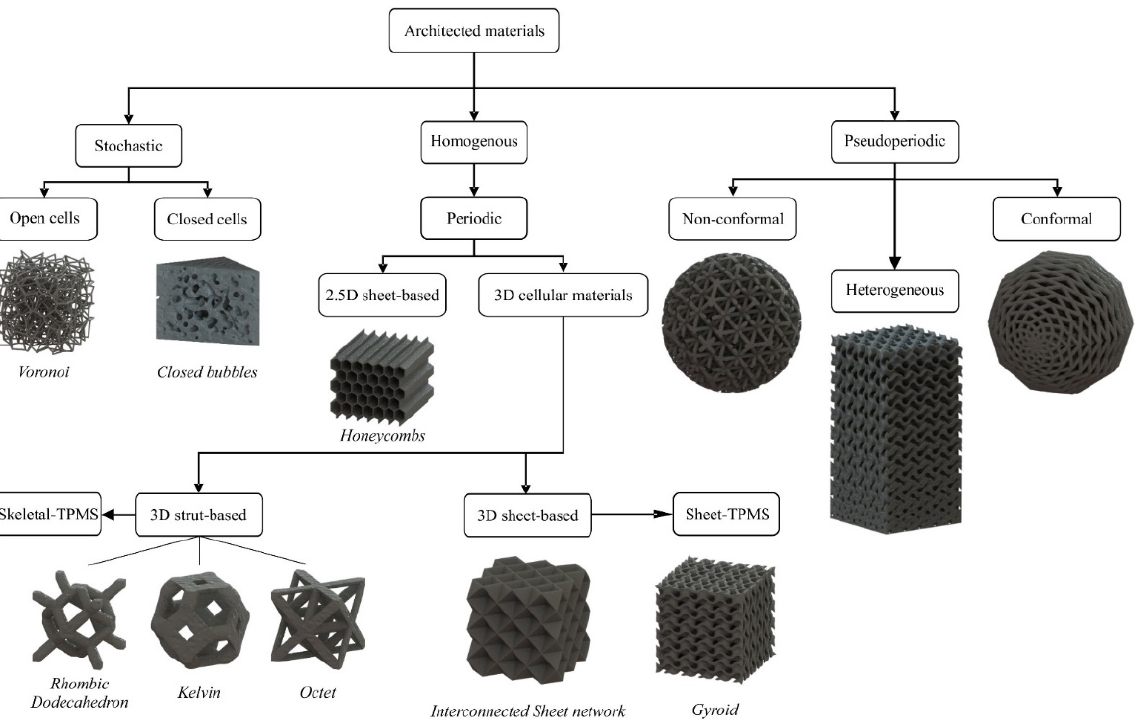
Figure 1. Classi fi cation of architected materials based on their geometry [19]. Figure 1. Classification of architected materials based on their geometry